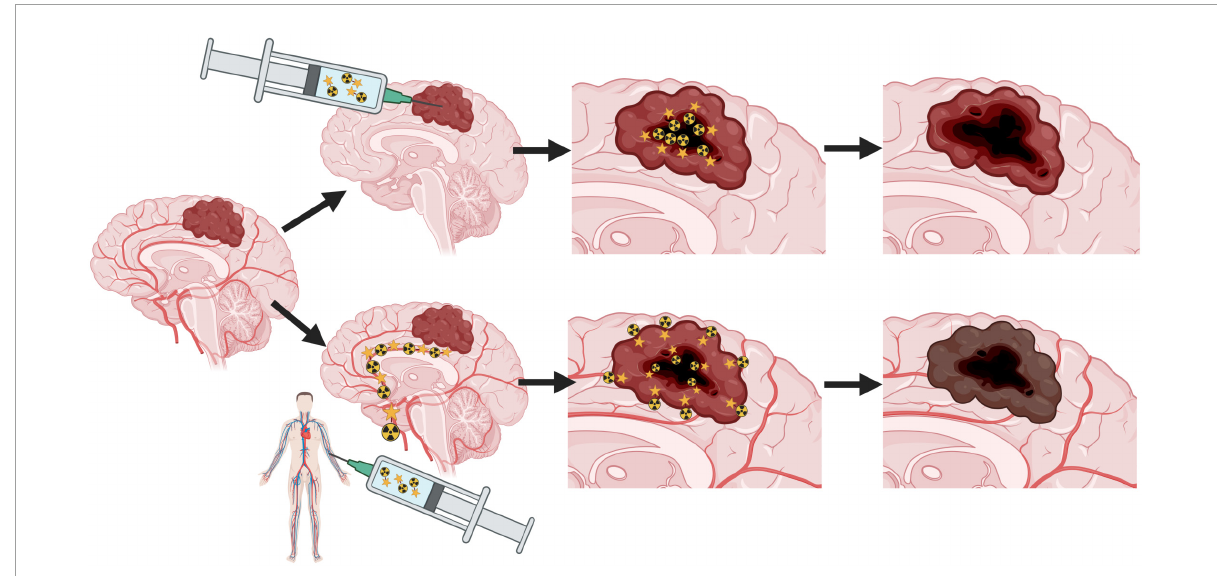
FIGURE1 The idea of theranostic treatment of glioblastoma with local and intravenous injection of